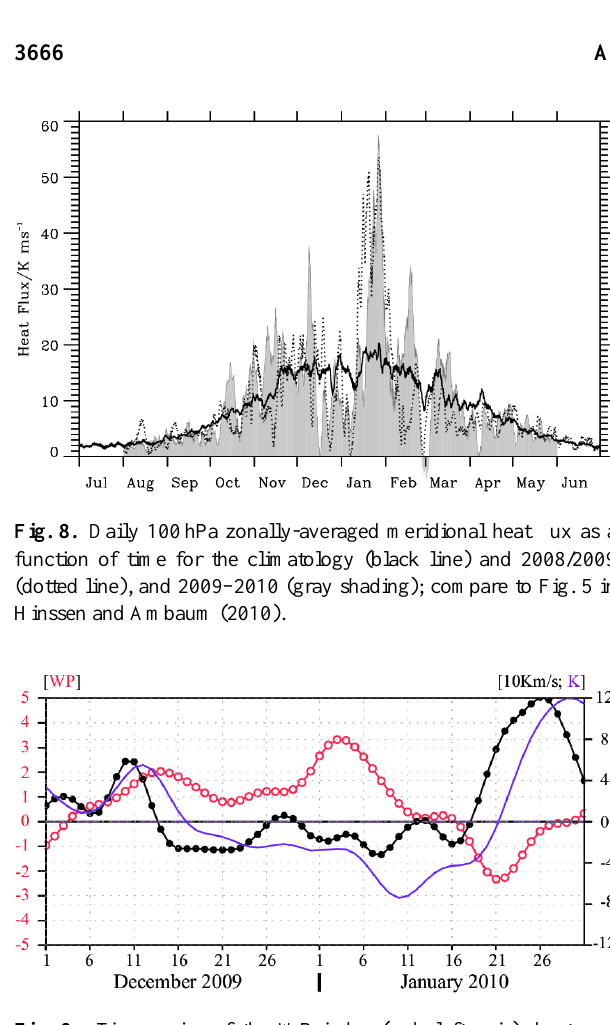
Figure 9: Time series of the WP index (red; left axis), heat flux anomaly ([V*T*] a ) from the 8-day low-pass filtered fields of meridional wind (V) and temperature (T) at the 100 hPa surface (45 °N-85 °N mean, 10 K m/s; black, right axis) as a measure of upward planetary wave propagation. Polar stratospheric temperature anomaly T a at 50 hPa (70 °N-90 °N mean, K; purple, right axis). The anomalies are calculated with respect to the JRA 1979-2007 climatology.